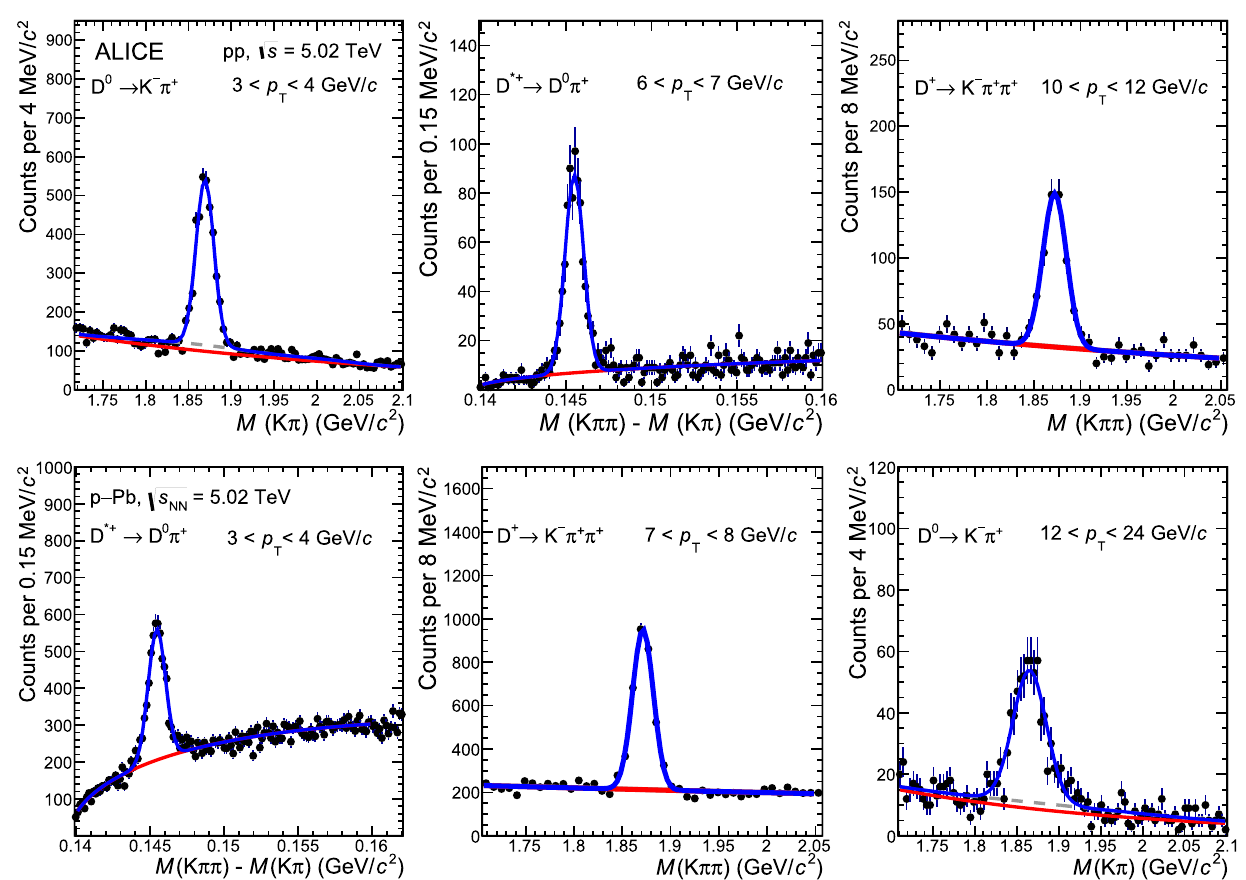
Fig. 1 Invariantmass(mass-difference)distributionsofD 0 ,D + (D ∗+ ), and charge conjugates, candidates in three p D √ s = 5 . 02 TeV (top row) and p–Pb collisions at at (bottom row). The curves show the fit functions applied to the distri-